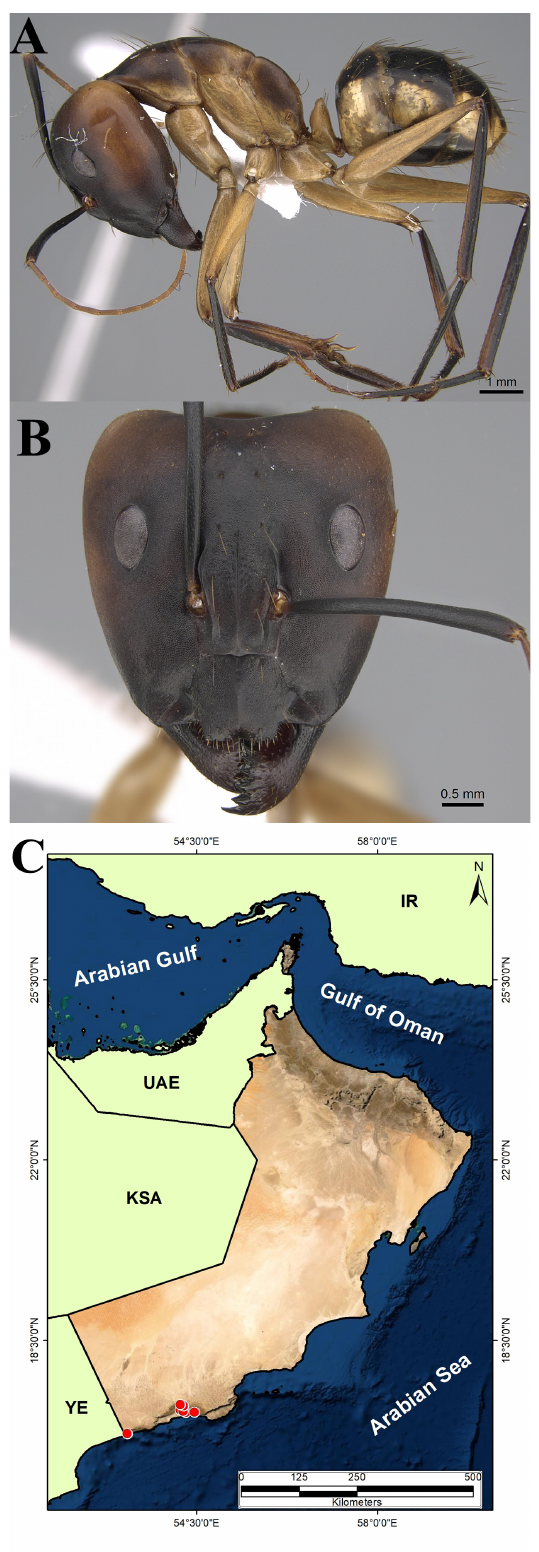
Fig. 3. Camponotus aegyptiacus Emery, 1915, major worker (CASENT0922849 , AntWeb.org (Michele Esposito )). A . Body in profile. B . Head in full-face view. C . Distribution